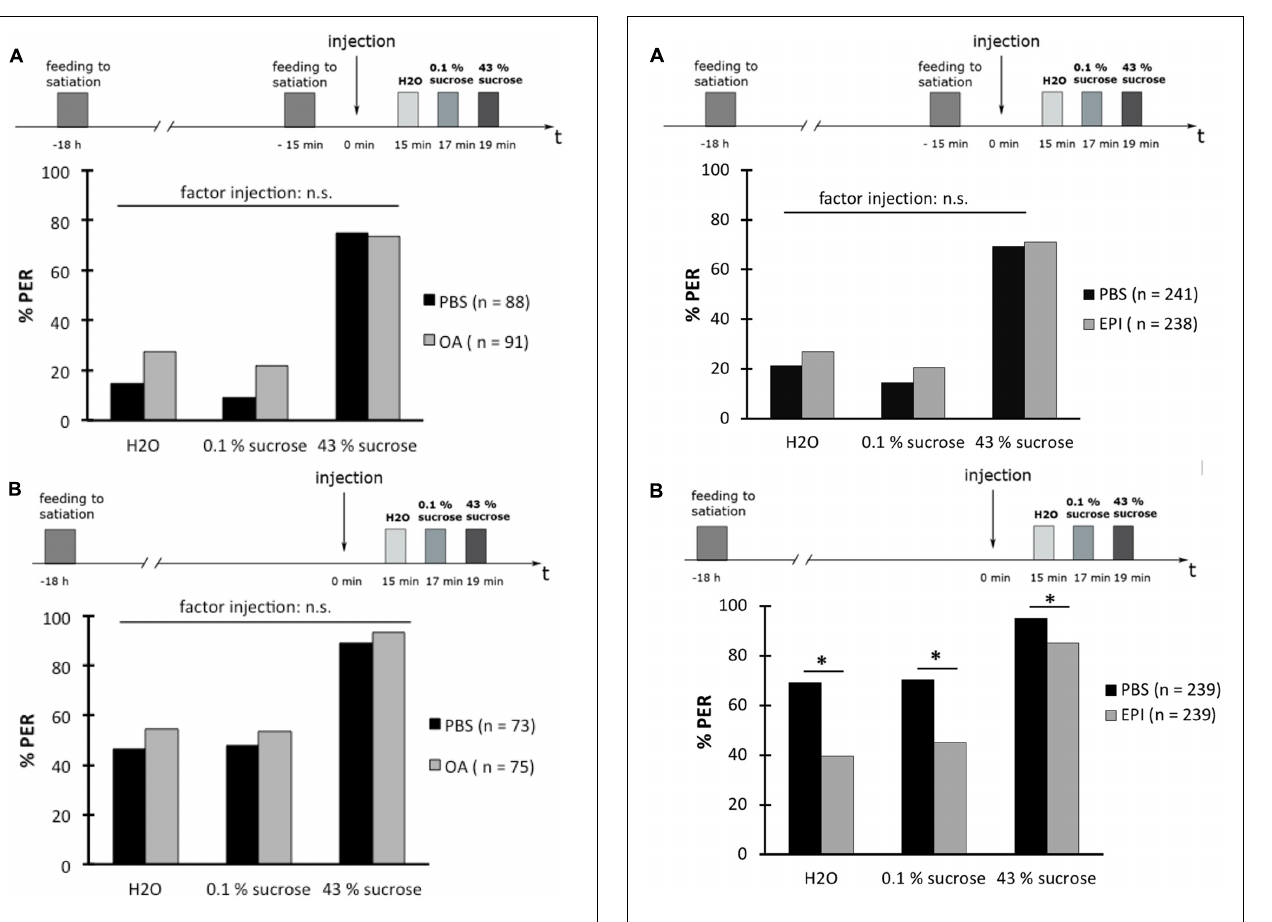
FIGURE 7 | Octopamine does not affect the proboscis extension response (PER) of hungry or sated honeybees. (A) Schematic overview of the experiment (above). Bees were fed to satiation with 30% (w/v) sucrose solution (0.88 M) 18 h and again 15 min before drug injection. The PER was tested 15 min after drug injection with water (H 2 O), with 0.1% (w/v) sucrose solution (2.9 mM) (0.1% sucrose), and with 43% (w/v) sucrose solution (1.25 M) (43% sucrose). Octopamine (OA) did not affect the PER to these different solutions in sated bees (below). (B) Schematic overview of the experiment (above). Bees were fed to satiation with 30% (w/v) sucrose solution (0.88 M) 18 h before drug injection. The PER was tested 15 min after drug injection as described in (A) . OA did not affect the PER to these different solutions in hungry bees (below). Number of bees appears in brackets.